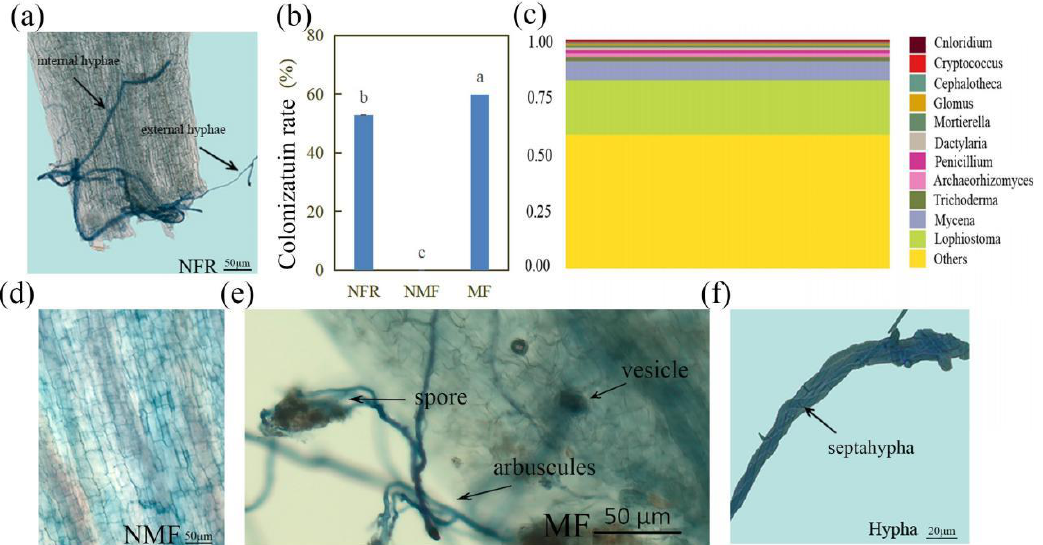
Figure 1. Microscopic observation and molecular identification of mycorrhizal fungi in fine roots collected from the natural forest and seedlings of C. paliurus . ( a ) mycorrhizal symbiosis in fine roots collected from the well-growing large trees grown in the natural forest (NFR) of C. paliurus ; ( b ) colonization rate; ( c ) the molecular identification of fungal richness in fine roots collected from the natural forest of C. paliurus ; ( d ) colonization observation in fine roots of seedlings without inoculation with mycorrhizal microbial inoculum (NMF); ( e ) colonization observation in fine roots of seedlings inoculated with mycorrhizal microbial inoculum (MF); ( f ) observation of hypha in fine roots of C. paliurus . All classifications are at the genera level; the genera of mycorrhizal fungi with abundance less than 0.5% and those with no classification were combined into the Other group.